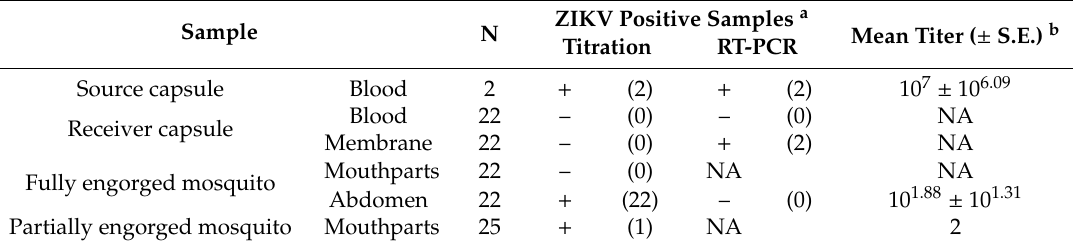
Table 1. Summary of the results from the di ff erent sample analyses.